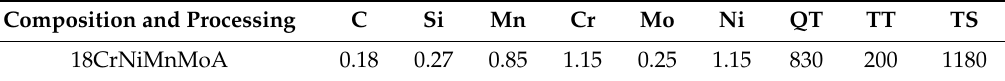
Table 4. 18CrNiMnMoA chemical composition.